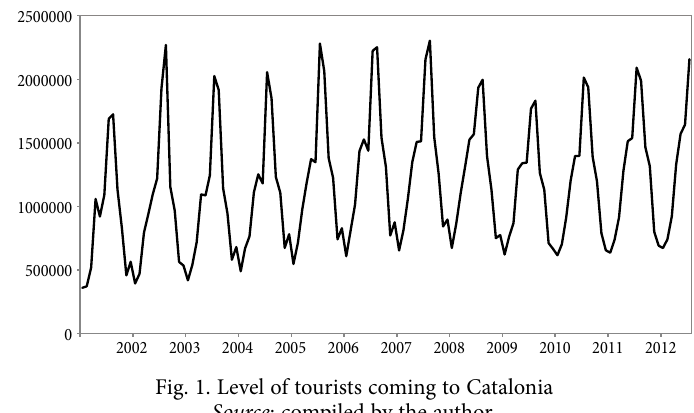
Fig. 1. Level of tourists coming to Catalonia Source : compiled by the